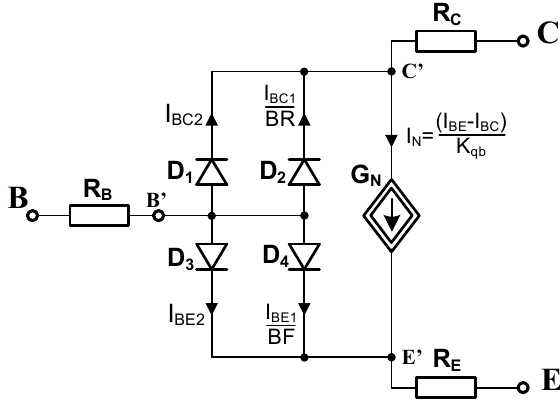
Figure 2. Network form of the electrical model of SiC BJT.